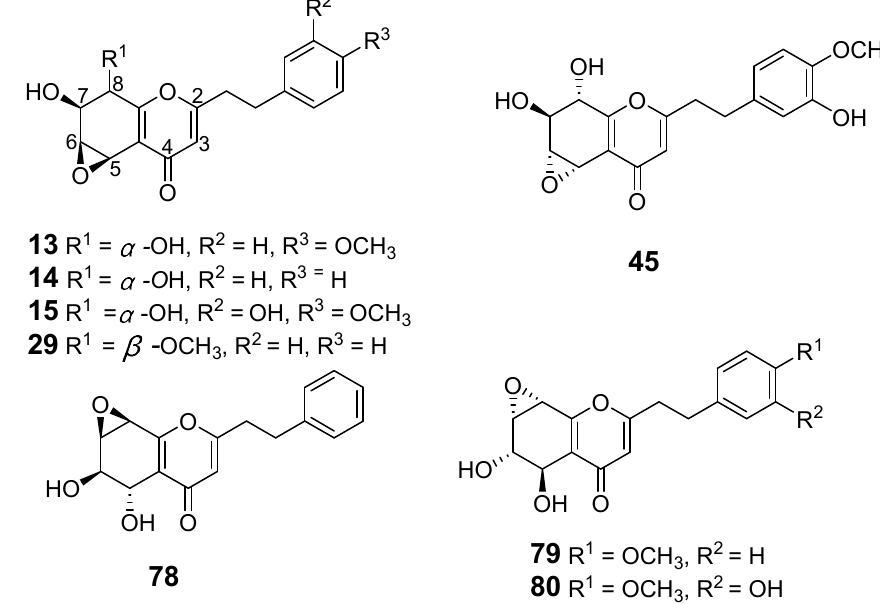
Figure 4. Structures of 5,6,7,8-tetrahydro-2-(2-phenylethyl)chromones with epoxide identified in agarwood.